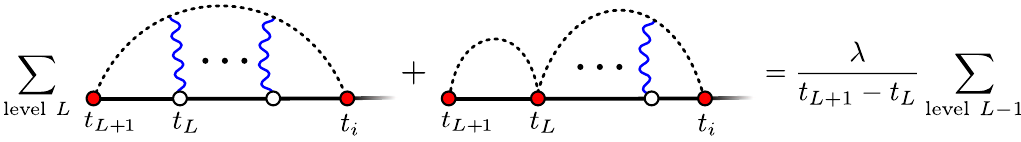
Figure 14 . The line integrand e F ( L ) satisfies a simple recursion relation 14. It is derived by summing up the two vertex possibilities at the last integration point t . The vertex can either be a gluon L insertion (4.10) or the ¯ ψ vertex insertion (4.11). The sum of the two yields the one lower loop integrand e F ( L − 1) , times λ/ ( t ) L +1 − t L